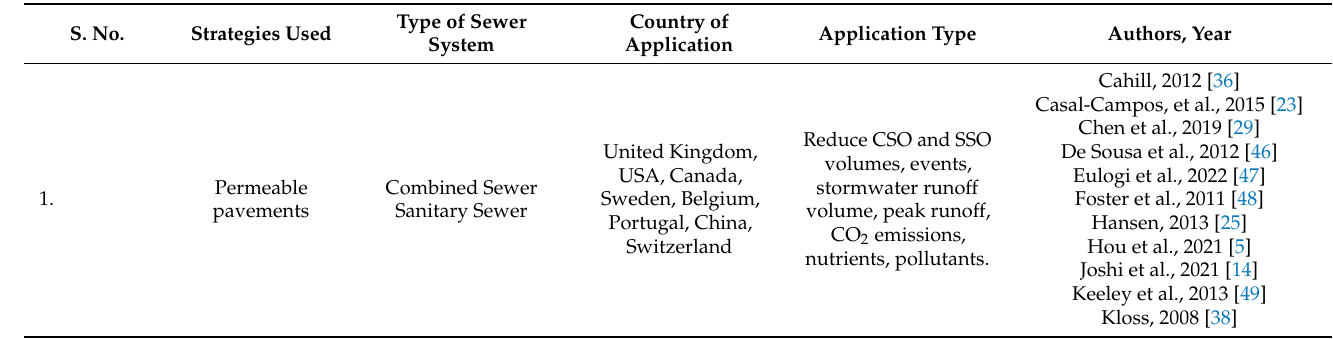
Table 1. A summary of articles reviewed in this